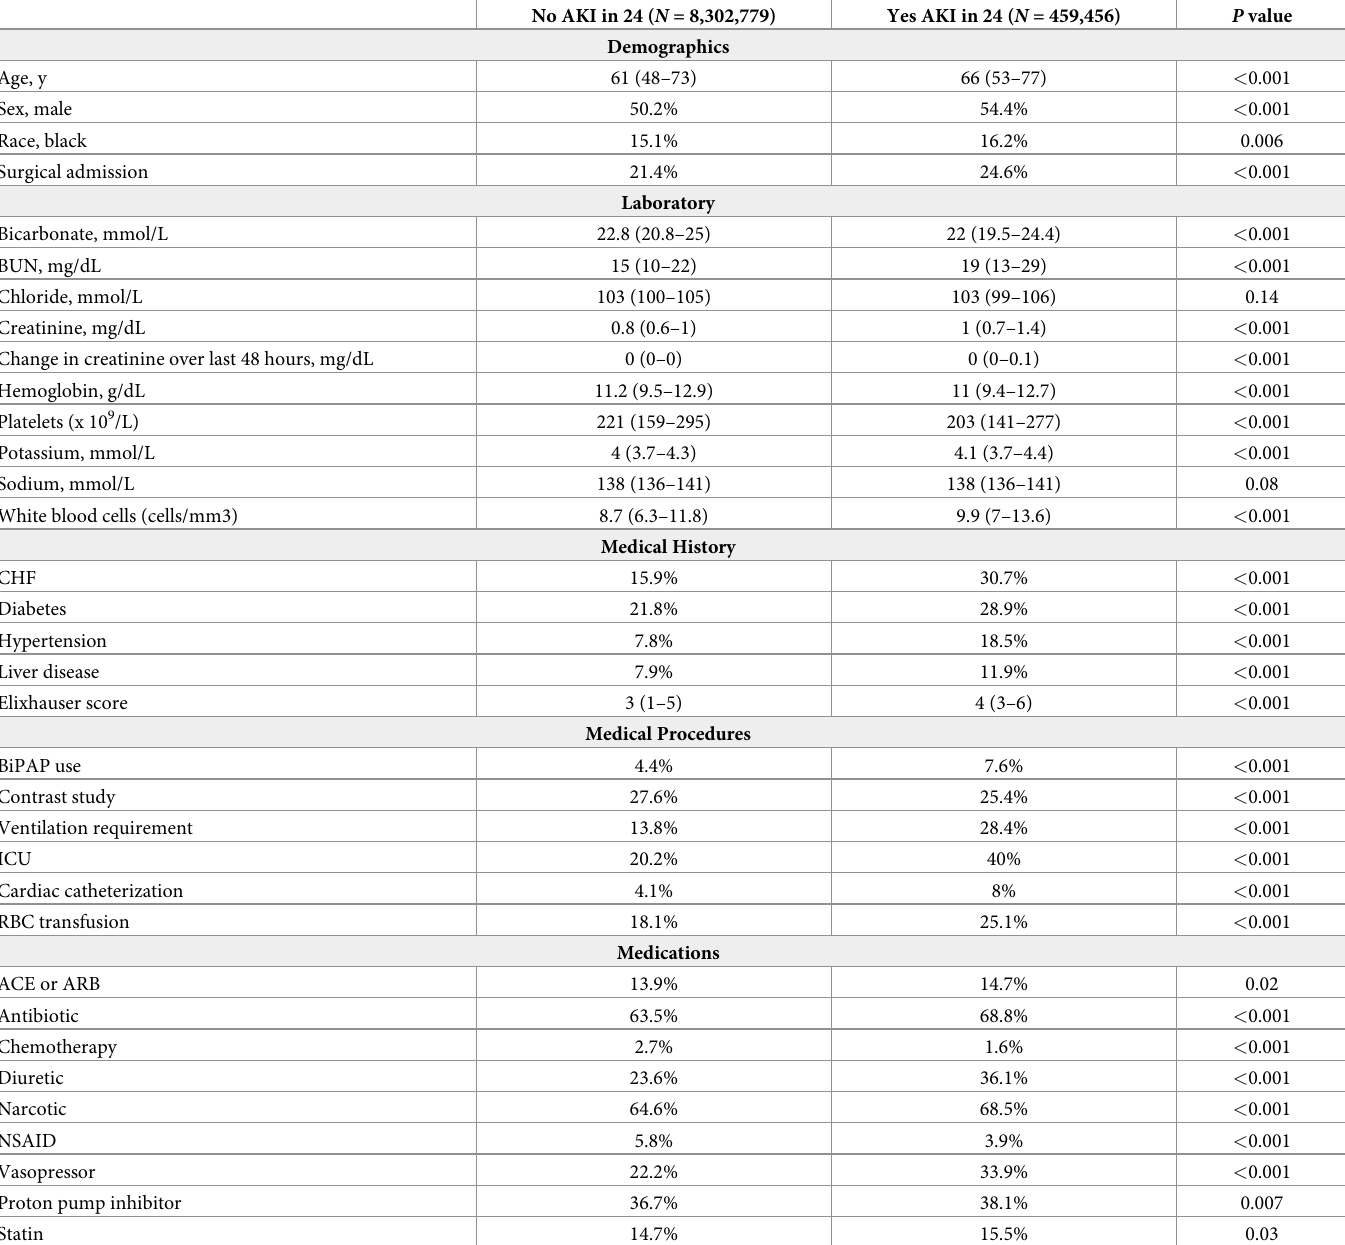
Table 3. Characteristics of patients at times not prior to AKI versus prior to AKI. Characteristics and univariable comparisons between times within 24 hours of AKI onset versus times not prior to AKI onset in the training set. Data is count (%) or median